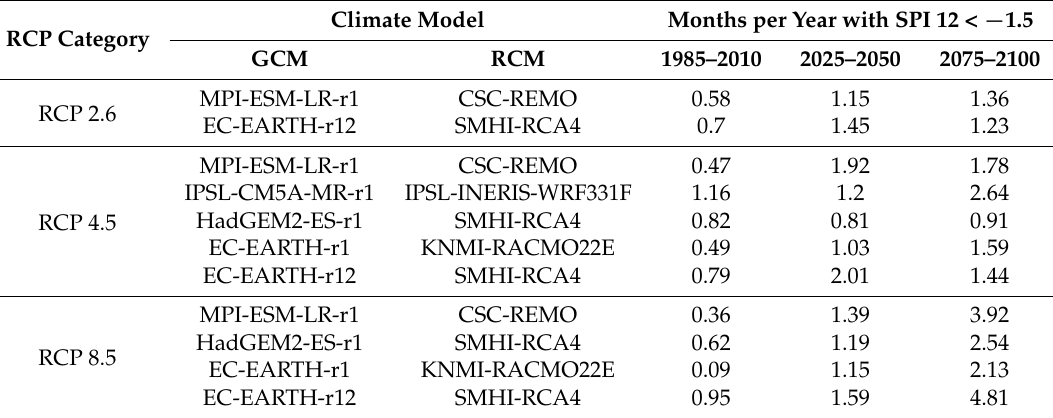
Table 3. Mean number of months with drought conditions per year (SPI12 < −